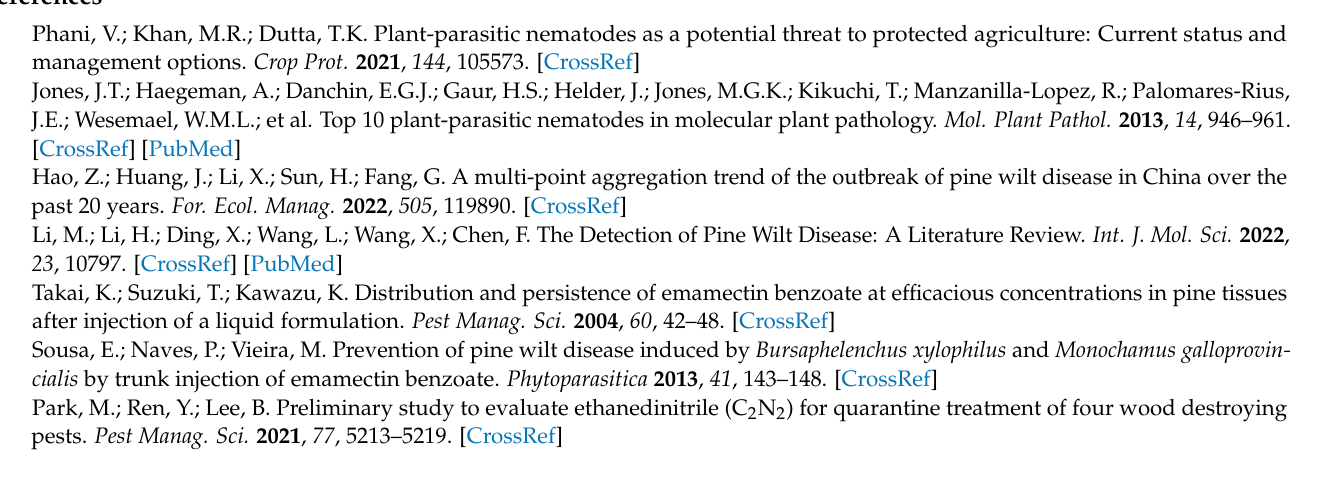
Figure S2: Up-regulated DEGs were identical when PWNs were exposed to A. robusta ; Table S1: The primers used for RT-qPCR; Table S2: Statistical analysis of RNA sequencing data; Table S3: The most important DEGs in PWNs; Table S4: Core genes in the